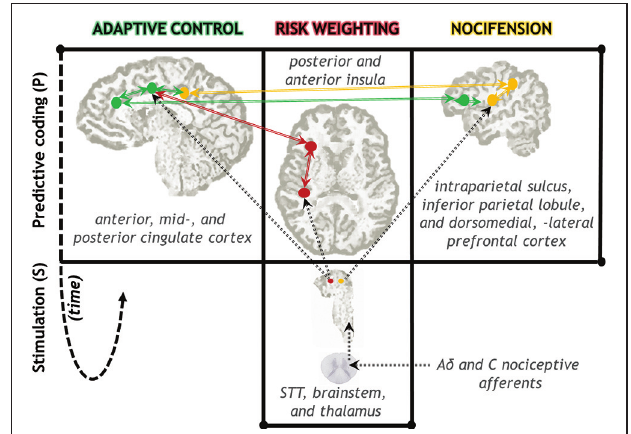
FIGURE 2 | Neuroanatomical diagram of key neural circuits in the PRA model of pain processing . Signals from nociceptive afferents arrive in cortex via STT, brainstem, and thalamic nuclei. The insula plays a central role in comparing these signals to predictions, as well as regulatory feedback processes that gain-modulate incoming signal weights (red; see also Figure 1). Spatiotemporal and proprioceptive information is integrated with pain information in parietal-centered circuits supporting nocifensive behavior (yellow). Voluntary actions in the face of actual or potential injury are supported by prefrontal regions, in particular anterior and mid-cingulate cortex (green). Action selection is likely to be influenced by risk-relevant information from the insula. Solid arrows indicate anatomical connectivity among highlighted regions. Dotted lines indicate selected major anatomical projections from the STT via thalamus. The time arrow (dotted fish-hook) indicates both the predictive (pre-stimulus) nature of these representations as well as the reiterative nature of the regulatory gain-setting processes. (Note: this schematic does not show all nociceptive-relevant regions and